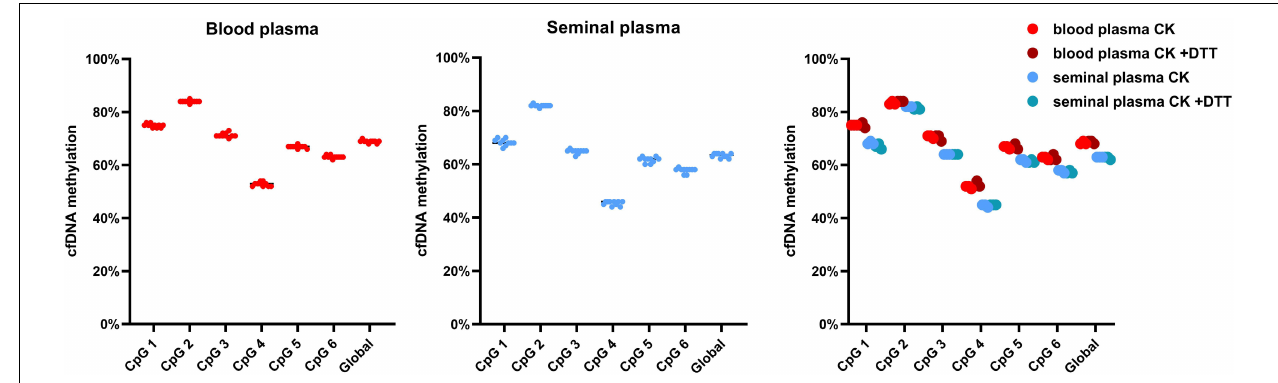
FIGURE 6 | Cell-free DNA methylation of LINE-1 in blood and seminal plasma. cfDNA methylation is depicted both as CpG specific and global, along with the impact of DTT on cfDNA methylation. Values represented are means. Every dot represents a different protocol